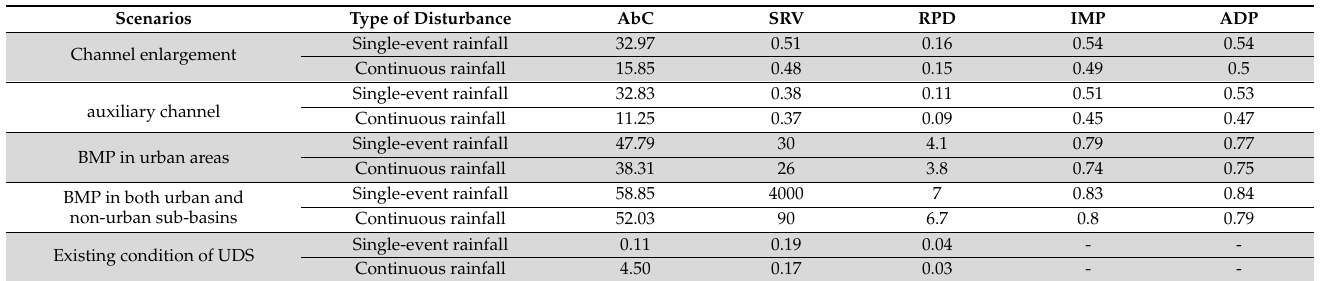
Table 6. The quantified (normalized) sub-factors of UDS flexibility for various scenarios for the hydraulic